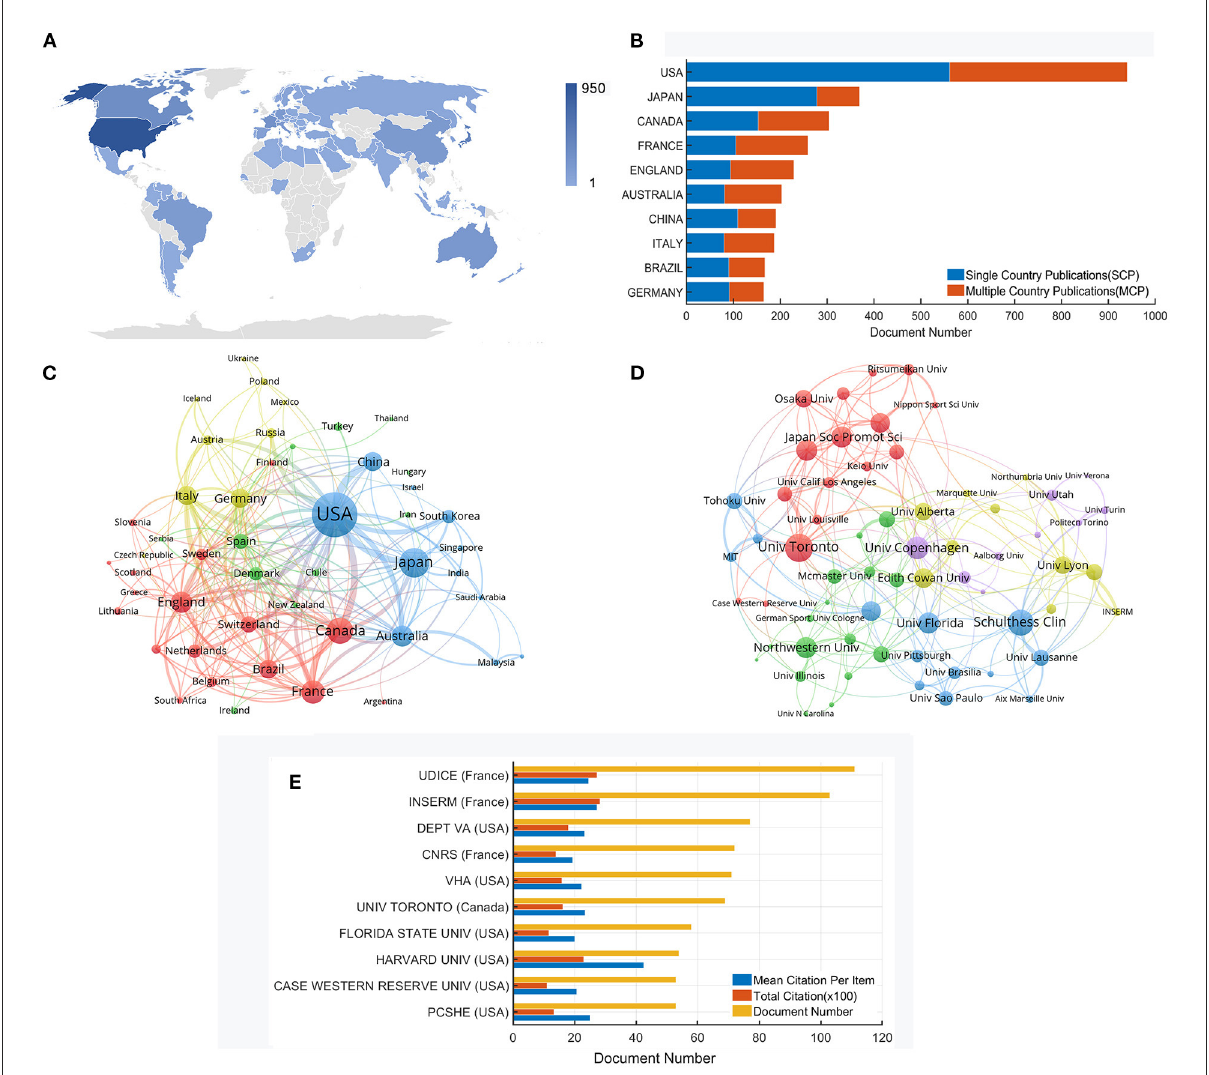
FIGURE3 (A) Distribution of countries/regions that contributed to research (the shade of the color bar reflects the number of literature). (B) Publication collaboration of the top 10 productive countries. (C) Network map of global collaborative relationships. (D) Co-authorship network map of institutions. (E) Citation analysis of the top 10 productive